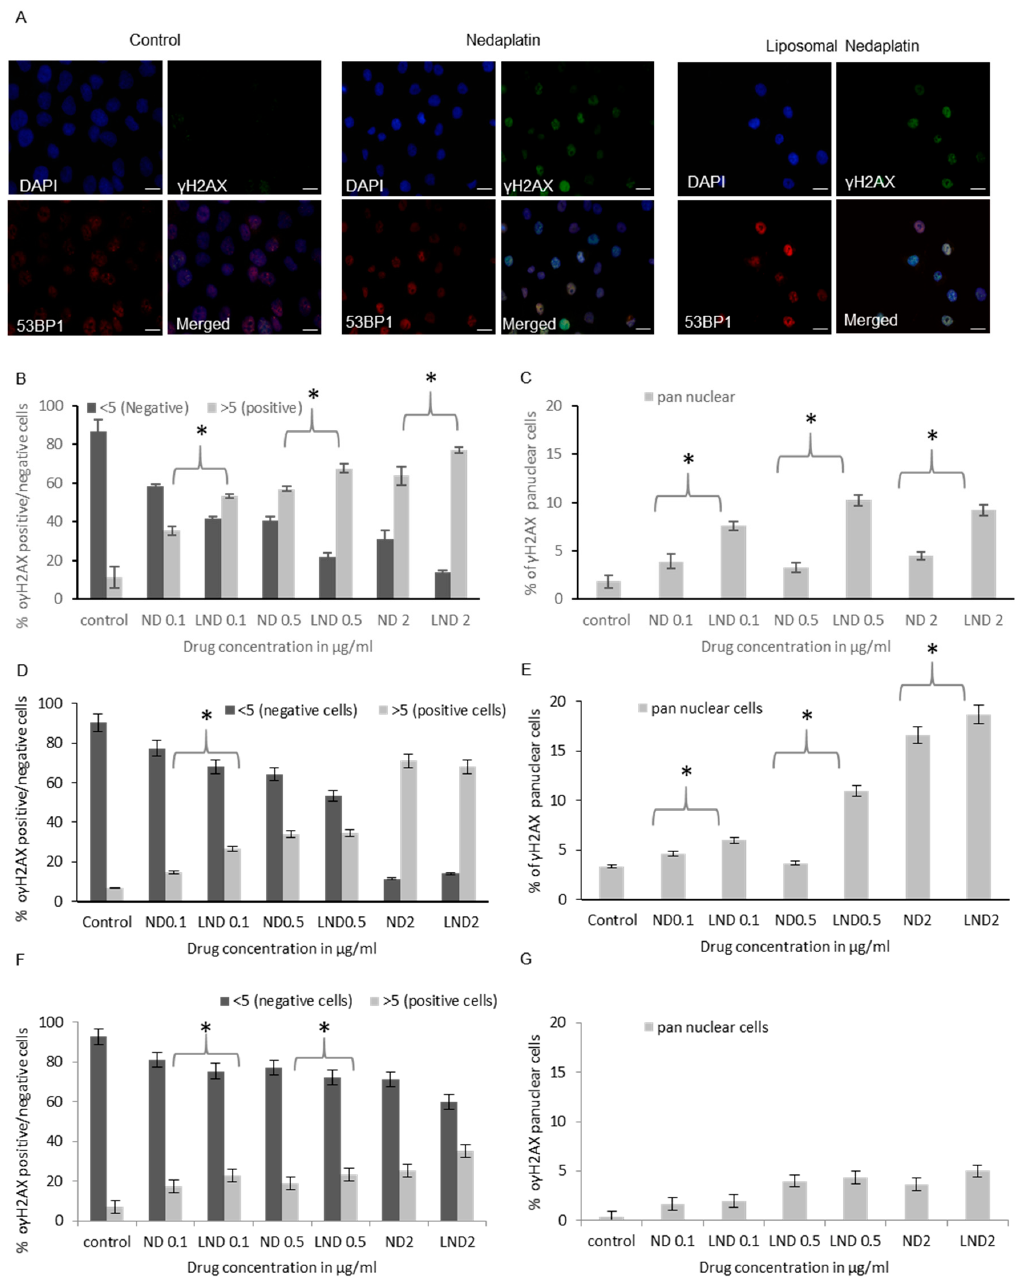
Figure 5. Genotoxicity of free and liposomal ND in cancer and noncancer cell lines assessed through γ H2AX induction. ( A ) Representative immunofluorescence images of control, ND and LND treated A549 cells. Quantification of γ H2AX positive and γ H2AX pan nuclear cells, respectively, in ( B , C ) A549, ( D , E ) U2OS, ( F , G ) WI-38 cells. While an overall statistically significant increase in the percentage of cells positive for DNA damage observed with LND compared to ND was shown in all cell lines, a statistically significant increase in the γ H2AX pan-nuclear signal was only observed with LND in the cancer cell lines ( p -value < 0.05). Multiple pair-wise t -tests showed the concentrations of treatment where a significant di ff erence between LND and ND DNA damage is observed. These points are indicated by asterisks * ( p < 0.05) in the charts above. Scale bars are 10 μ m.